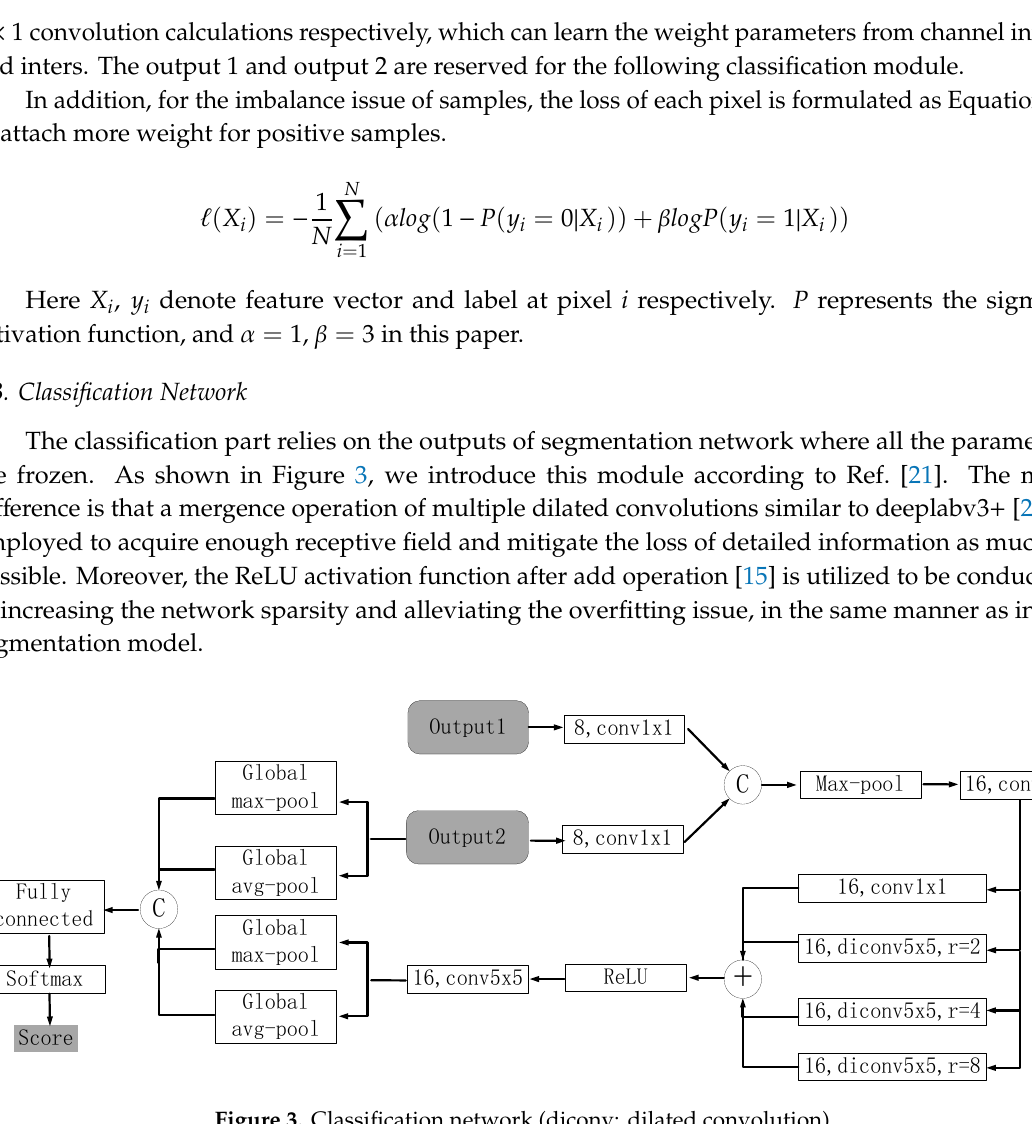
Figure 3 . Classification network (diconv: dilated convolution) . Figure 3. Classification network (diconv: dilated